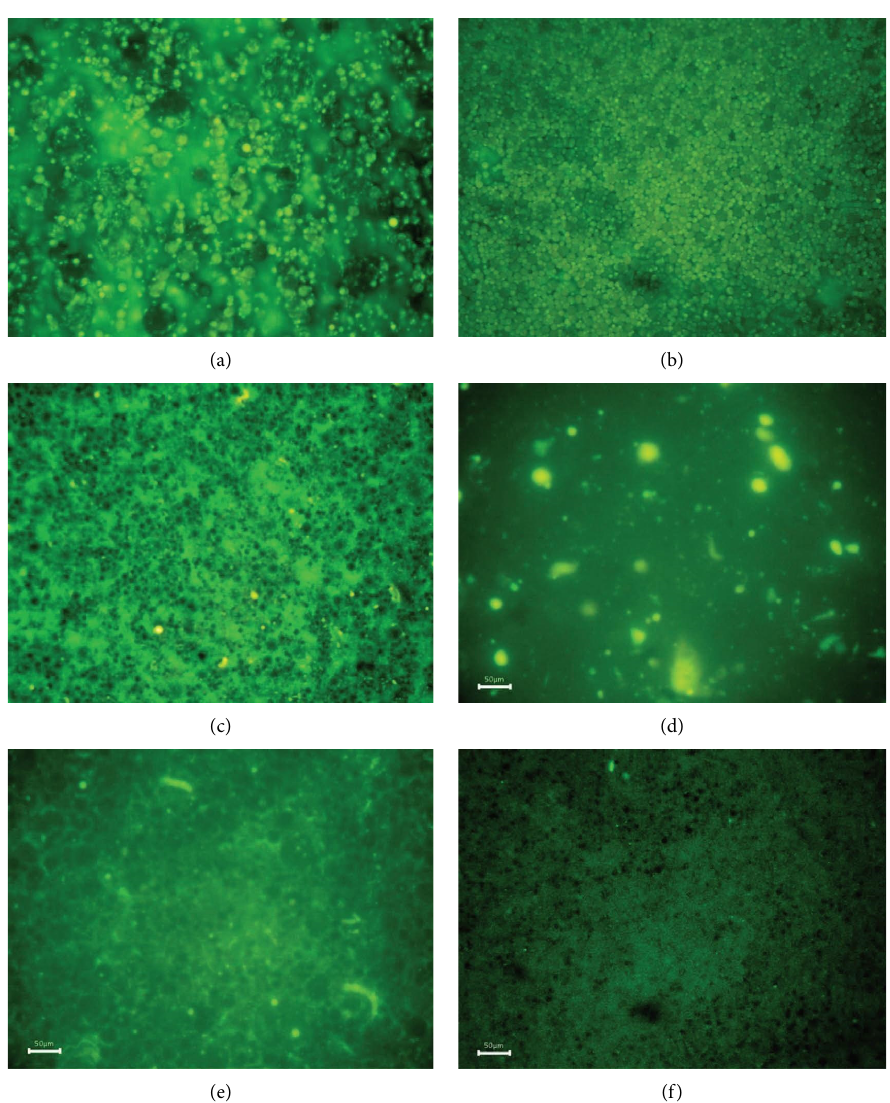
Figure 11: Microstructure of various modifed emulsifed asphalts under the fuorescence microscope. (a) 1.5% SBS modifed emulsifed asphalt ( × 400). (b) 3% SBR modifed emulsifed asphalt ( × 400). (c) SBS/SBR modifed emulsifed asphalt ( × 100). (d) SBS/SBR modifed emulsifed asphalt evaporation residue ( × 400). (e) SBS/SBR modifed emulsifed asphalt before demulsifcation ( × 400). (f) SBS/SBR modifed emulsifed asphalt after demulsifcation ( ×